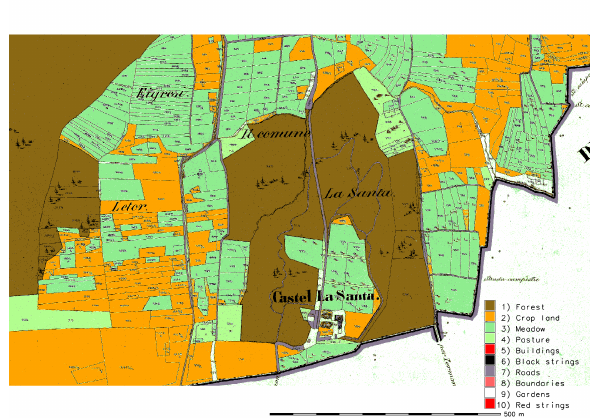
Figure 2. Classified map for unsupervised MLC - particular.